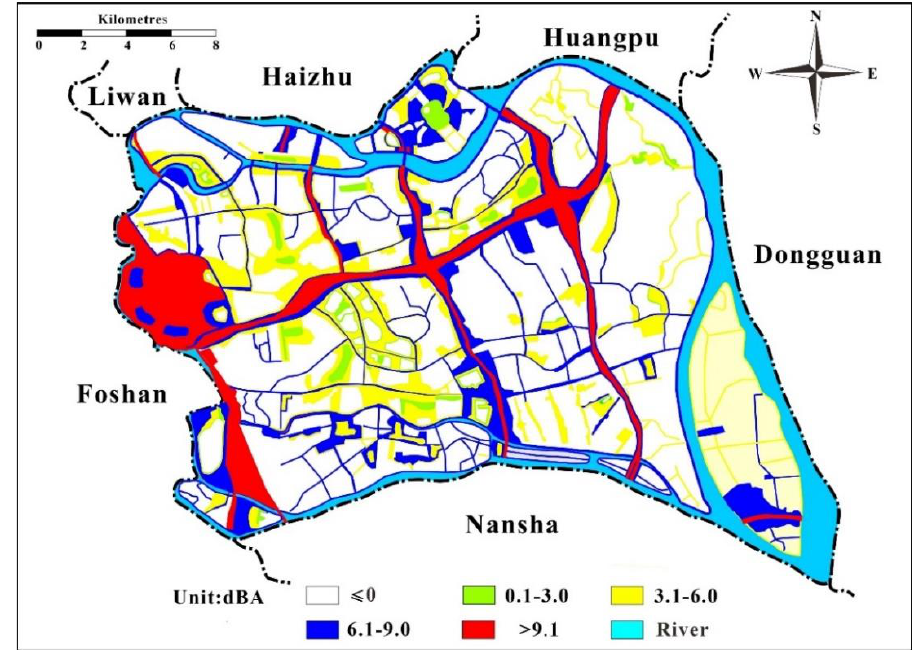
Figure 1. Daytime over-limit value map in Panyu District of Guangzhou City.